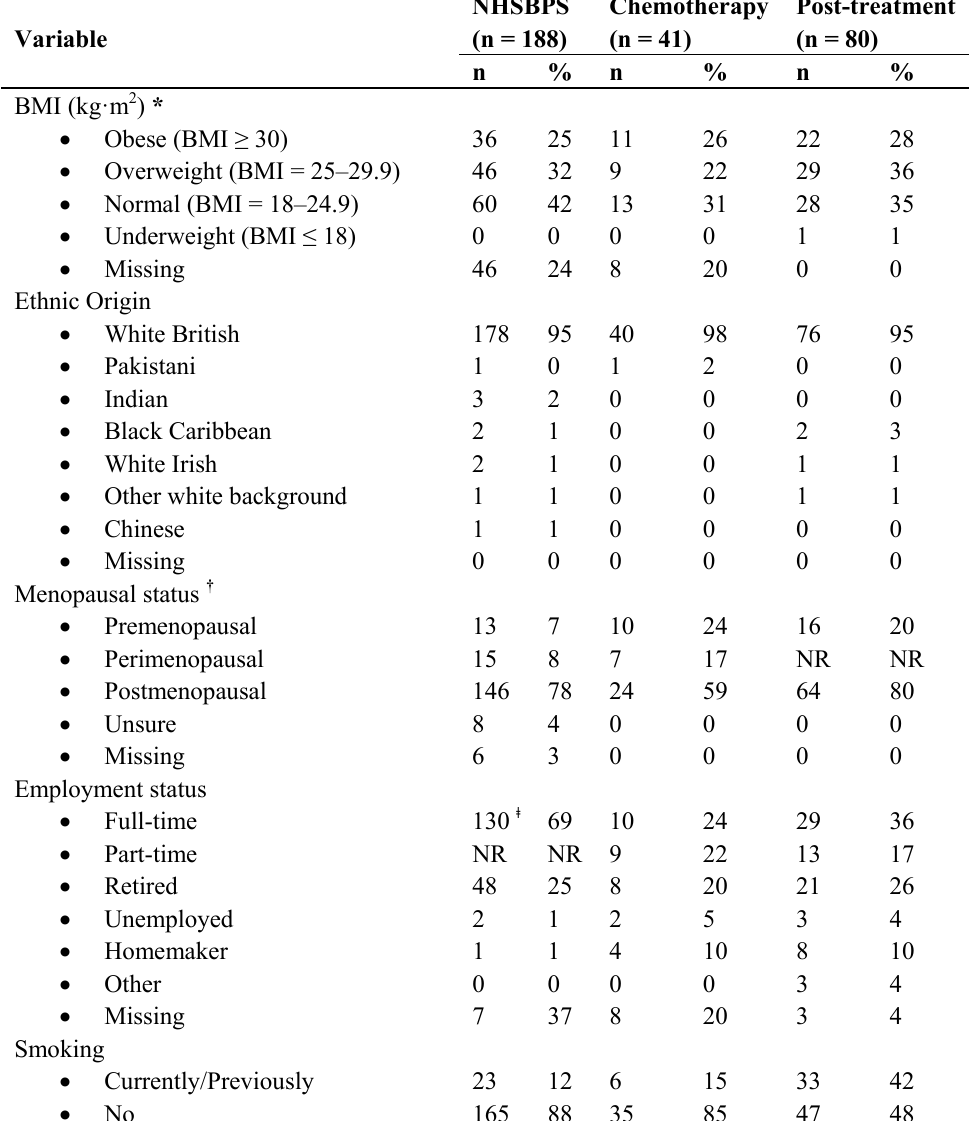
Table 1. Anthropometric, demographic and lifestyle characteristics of the